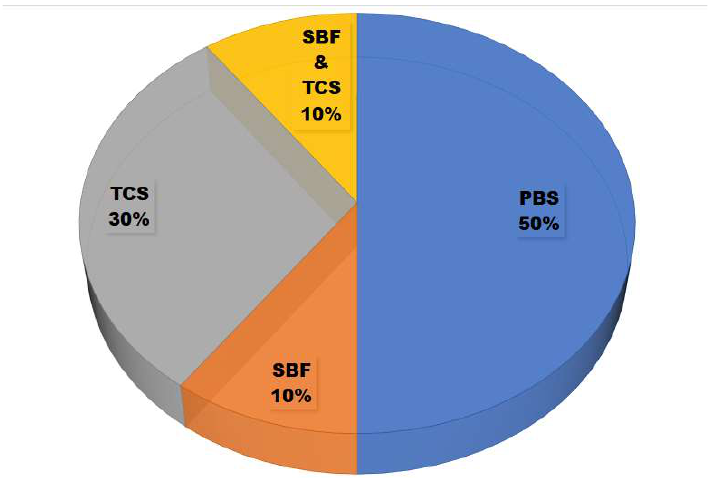
Figure 5. Solutions used for in vitro degradation tests to determine the weight loss of eggshell-based hydroxyapatite.